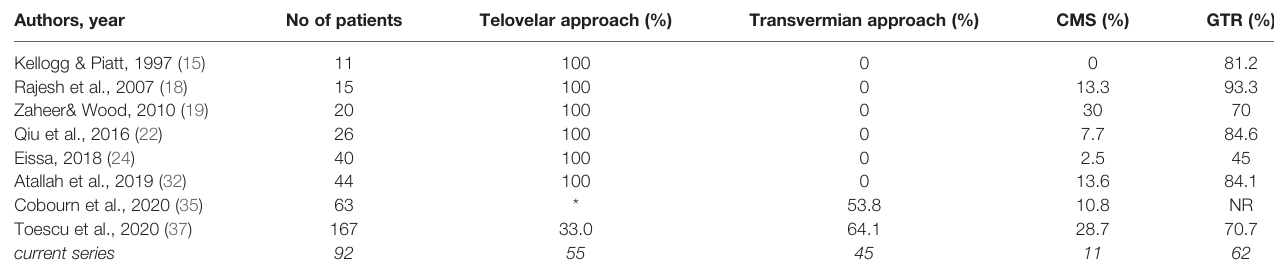
TABLE 5 | Surgery of fourth ventricle tumors: published pediatric case series. Authors,